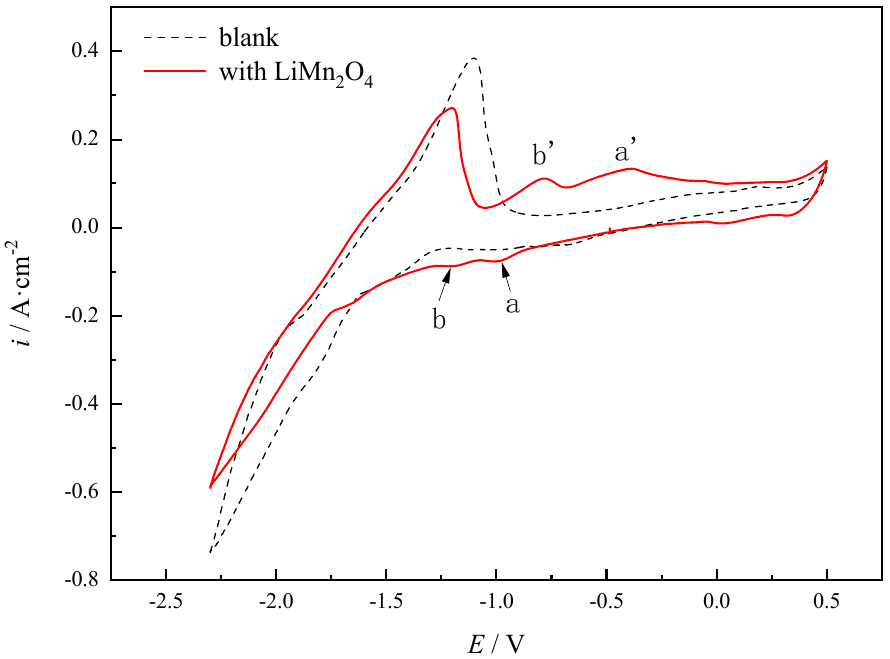
Figure 5. Cyclic voltammetry on the surface of Pt electrode (s = 0.159 cm 2 ) before and after adding LiMn 2 O 4 with 2 g to NaCl-CaCl 2 molten salt ( T = 750 °C, RE: Pt electrode, scanning speed: 0.2 V). Selected the scan range from − 2.4 to 0.5 V. The dashed line in Figure 5 shows the obvi- ous reduction peak at − 2.4 V in the reverse scanning direction. This is due to the